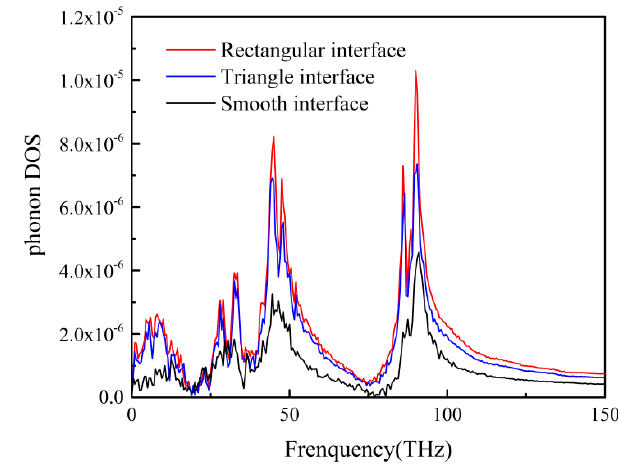
Figure 9. Variations of ITR with different interface morphologies.